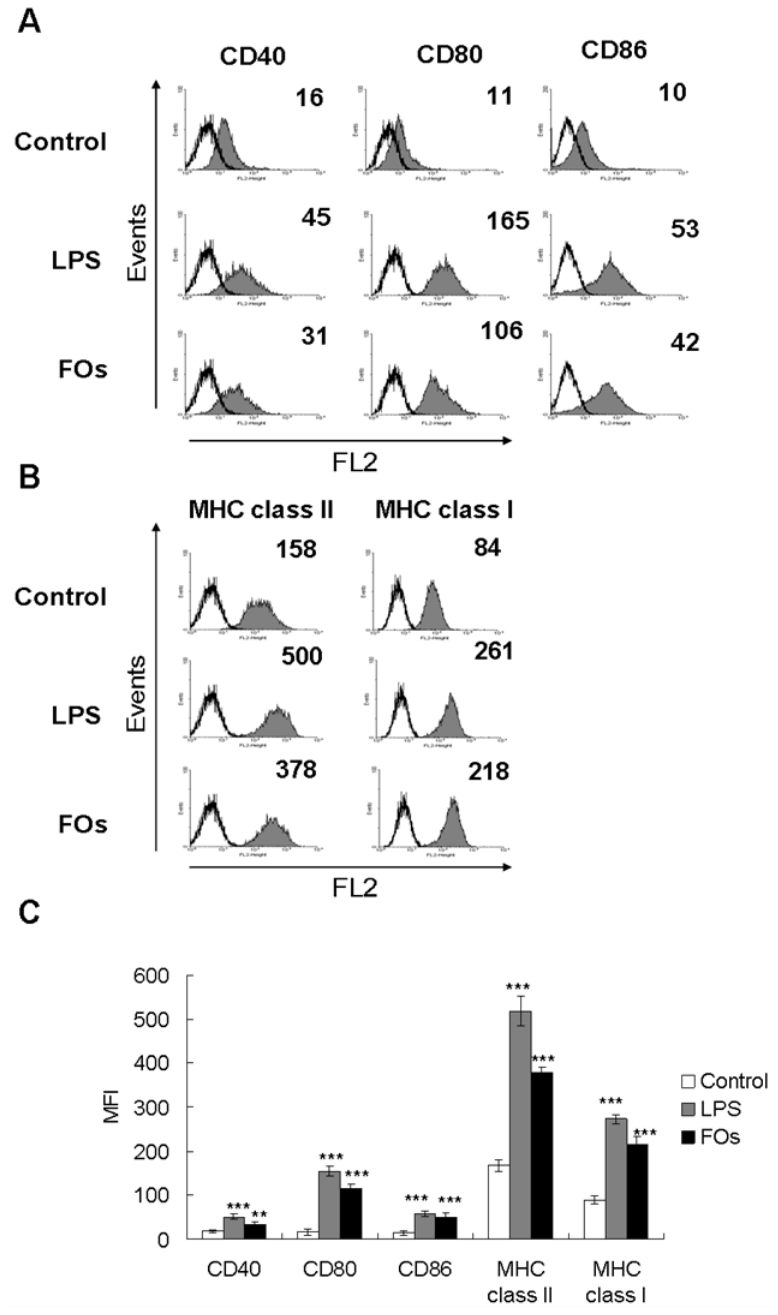
Figure 2. FOs up-regulate the expression of co-stimulatory molecules and MHC proteins on BMDCs Immature DCs were treated with 50 μ g FOs or 100 ng/mL LPS for 24 h. After incubation, cells were stained with specific primary antibodies against ( A ) Co-stimulatory molecules CD40, CD80, CD86 or ( B ) MHC proteins, MHC class I, MHC class II which was followed analyzed by flow cytometry. The gray-filled area represents staining with specific primary antibody. The open histogram represents staining with isotype control group. Data were shown as the mean fluorescence intensity (MFI). The histogram shows data from one representative experiment of each group. ( C ) The bar graphs represent the mean ± SD from triplicate well measurements from one of three independent experiments with similar results. ** p < 0.01, *** p < 0.001; versus PBS-treated DC